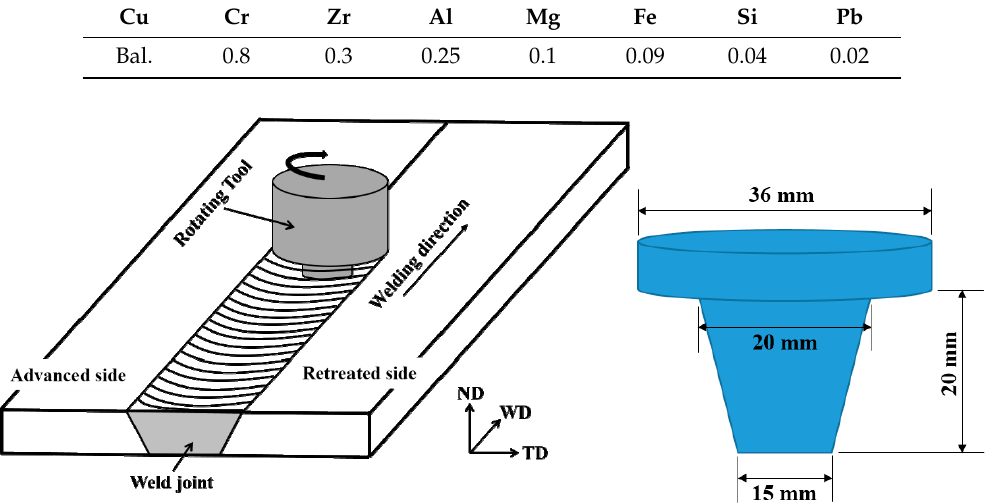
Table 1. The chemical compositions of the copper-chromium-zirconium alloy plate.